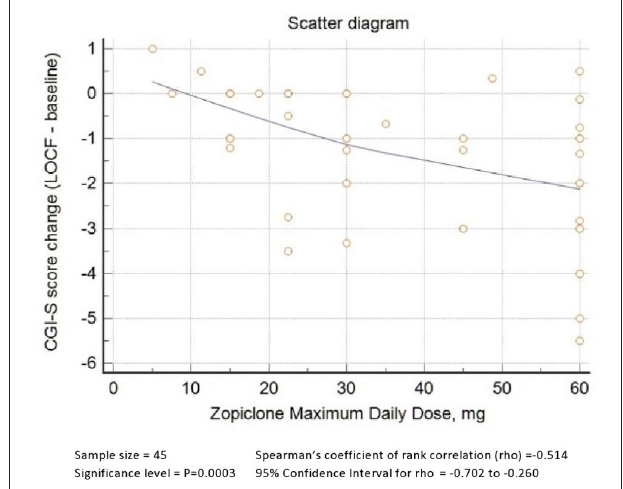
FIGURE 1 | Scatter diagram. Zopiclone maximum daily dose by CGI-S score